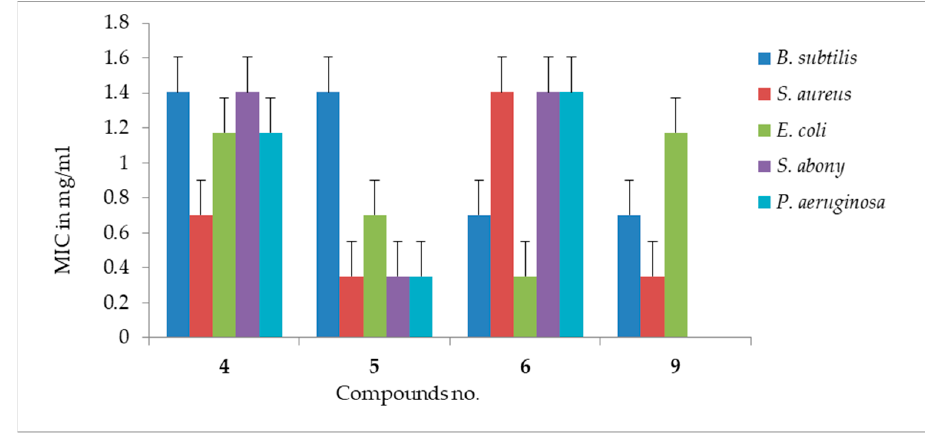
Figure 1. MIC values of some compounds against tested organisms.